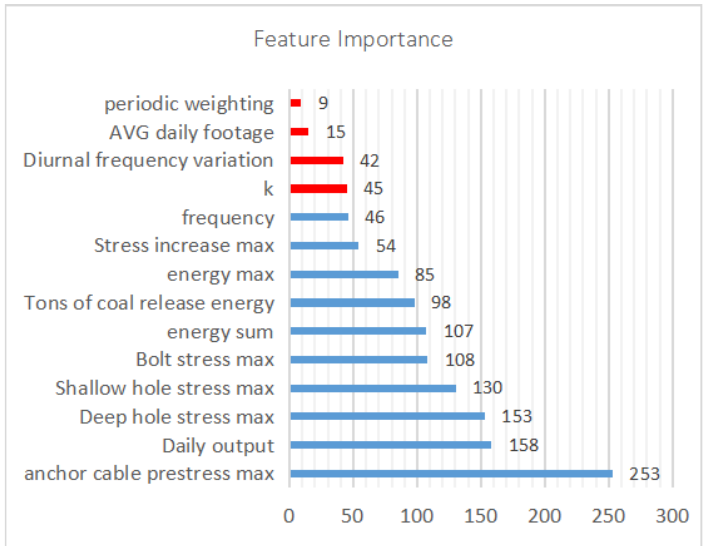
Figure 2. The importance of each characteristic variable of rockburst.